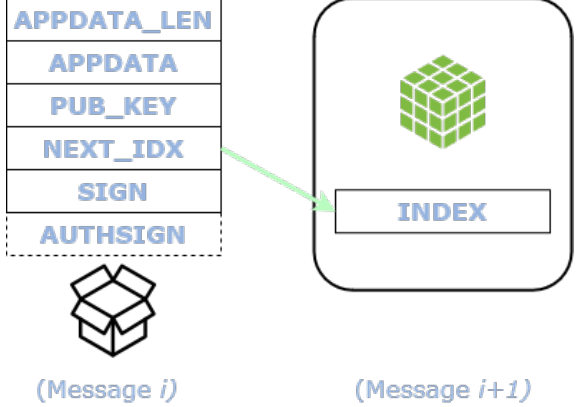
Figure 3. Chaining of L2Sec messages to realize a data stream.